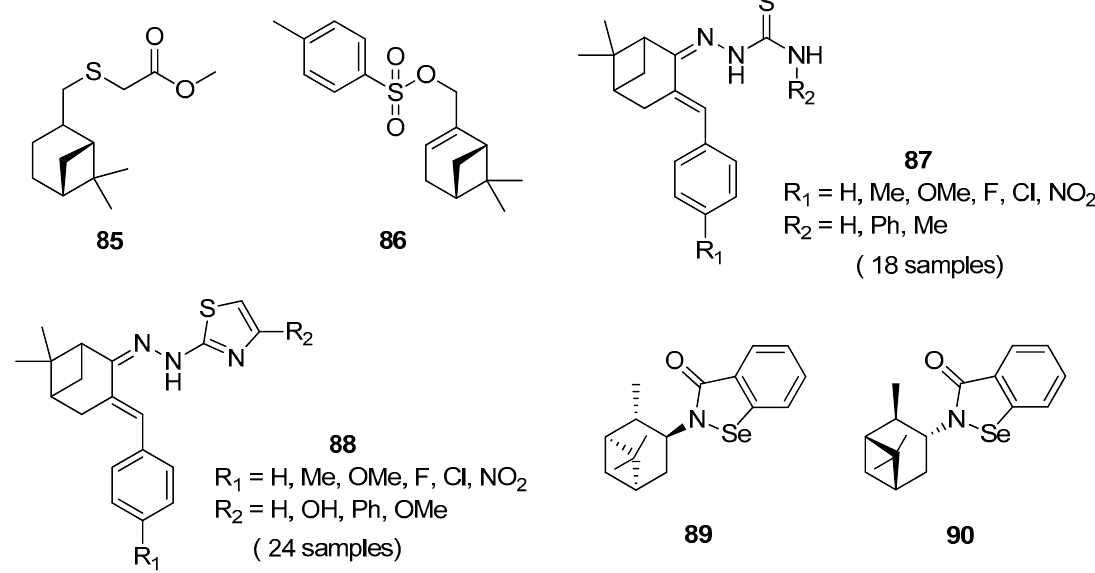
Figure 20. Representative pinene derivatives with pharmacological activity.